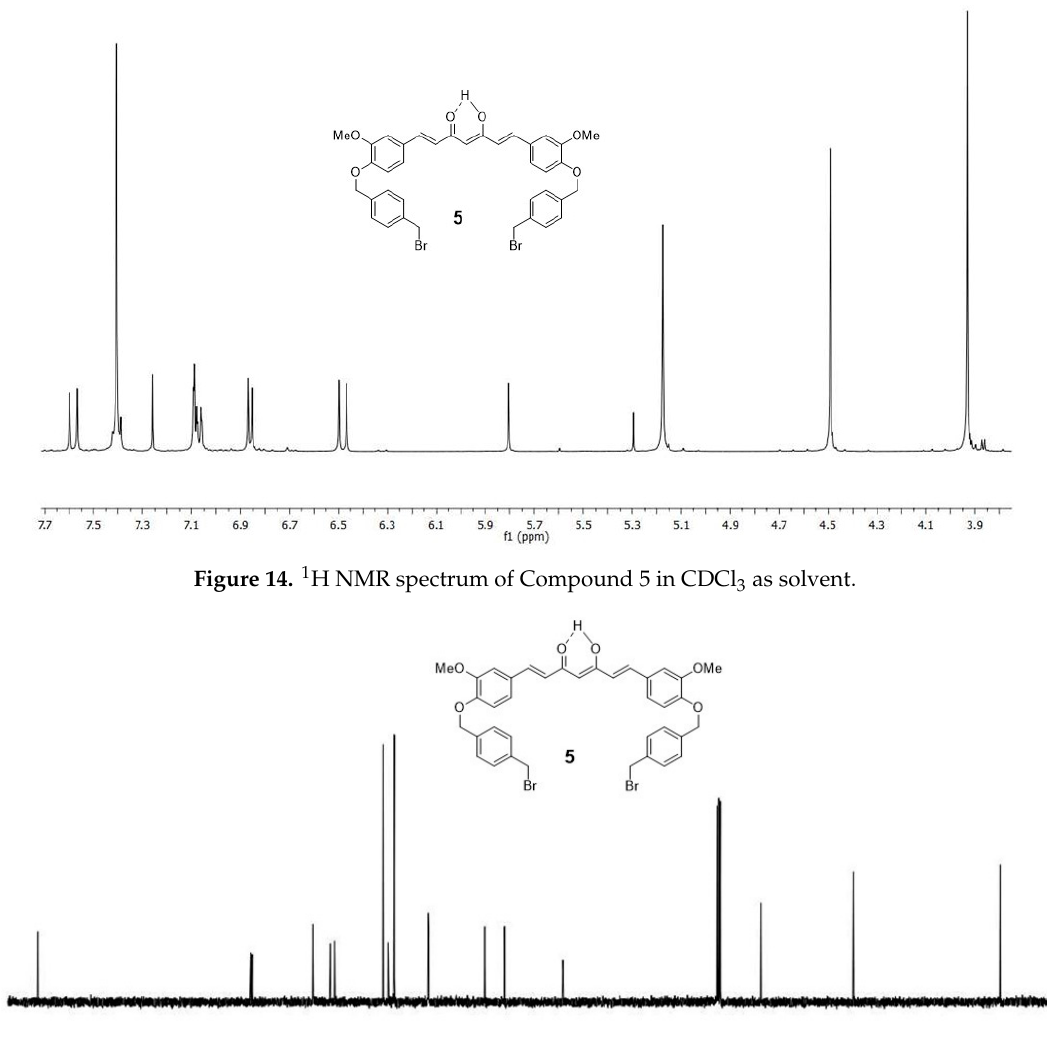
Figure 13. Structure of Compounds 4 and 5.